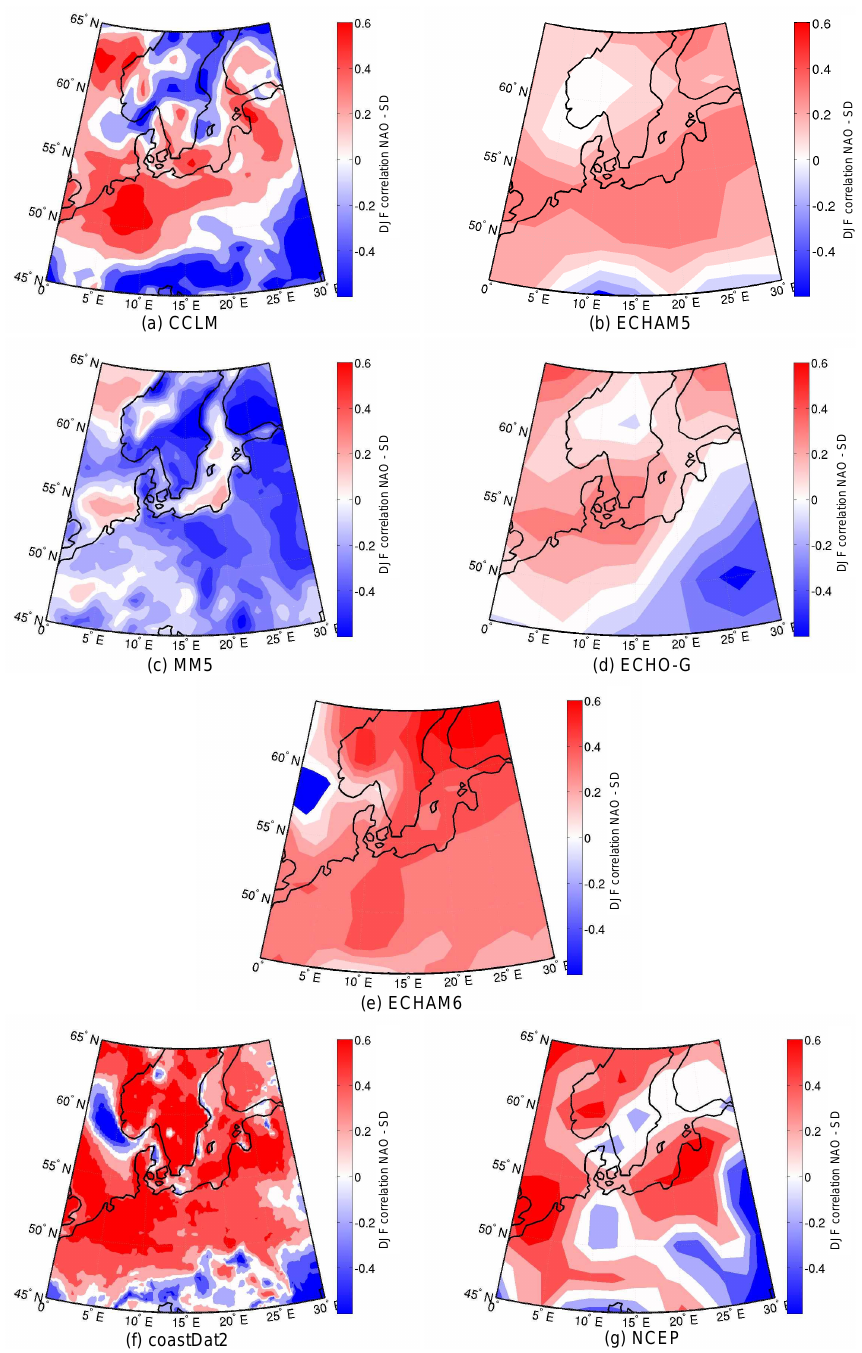
Figure 6. Correlation between NAO index and standard deviation of wind speed for seven different data sets: (a) CCLM (1655–1999 AD), (b) ECHAM5 (850–2005 AD), (c) MM5 (1001–1990 AD), (d) ECHO-G (1001–1990 AD), (e) ECHAM6 (850–2005 AD), (f) coastDat2 (1948–2012 AD), (g) NCEP (1948–2012 AD).